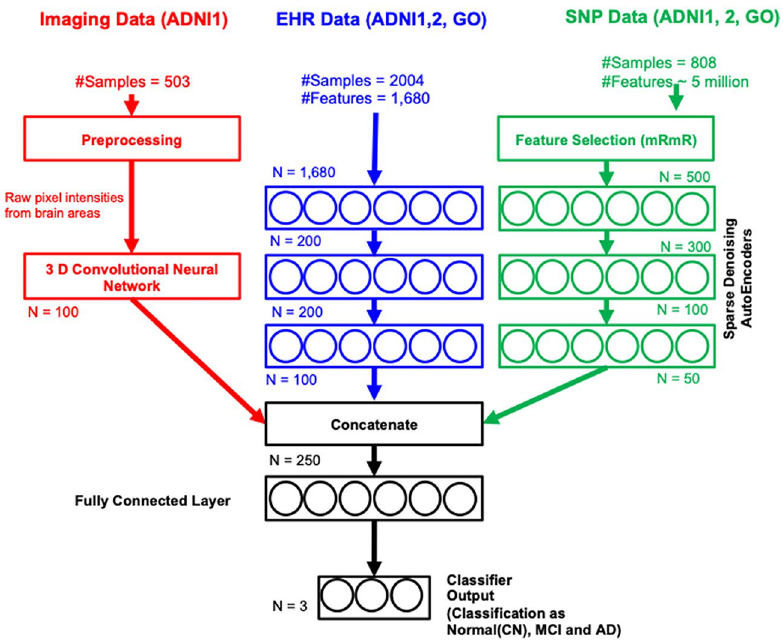
Figure 3. Intermediate-feature-level combination deep models for multimodality data integration for clinical decision support. Data from diverse sources, imaging, EHR and SNP are combined using novel deep architectures. 3D convolutional neural network architectures used on 3D MR image regions to obtain intermediate imaging features. Deep stacked denoising autoencoders are used to obtain intermediate EHR features. Deep stacked denoising autoencoders are used obtain intermediate SNP features. The 3 types of intermediate features are passed into a classification layer for classification into Alzheimer’s stages (CN, MCI and